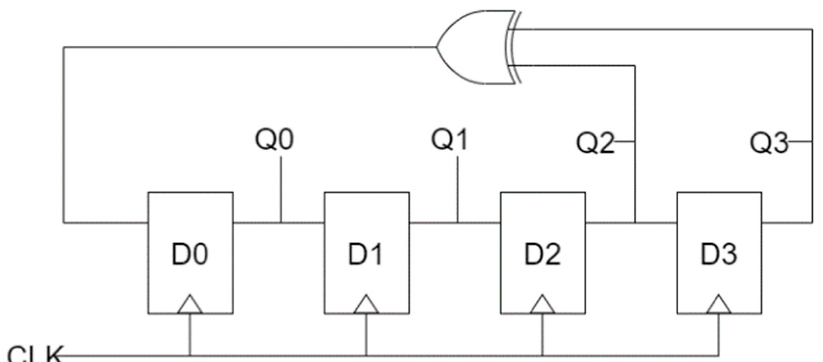
Figure 8. A logic diagram of 4-bit LFSR.